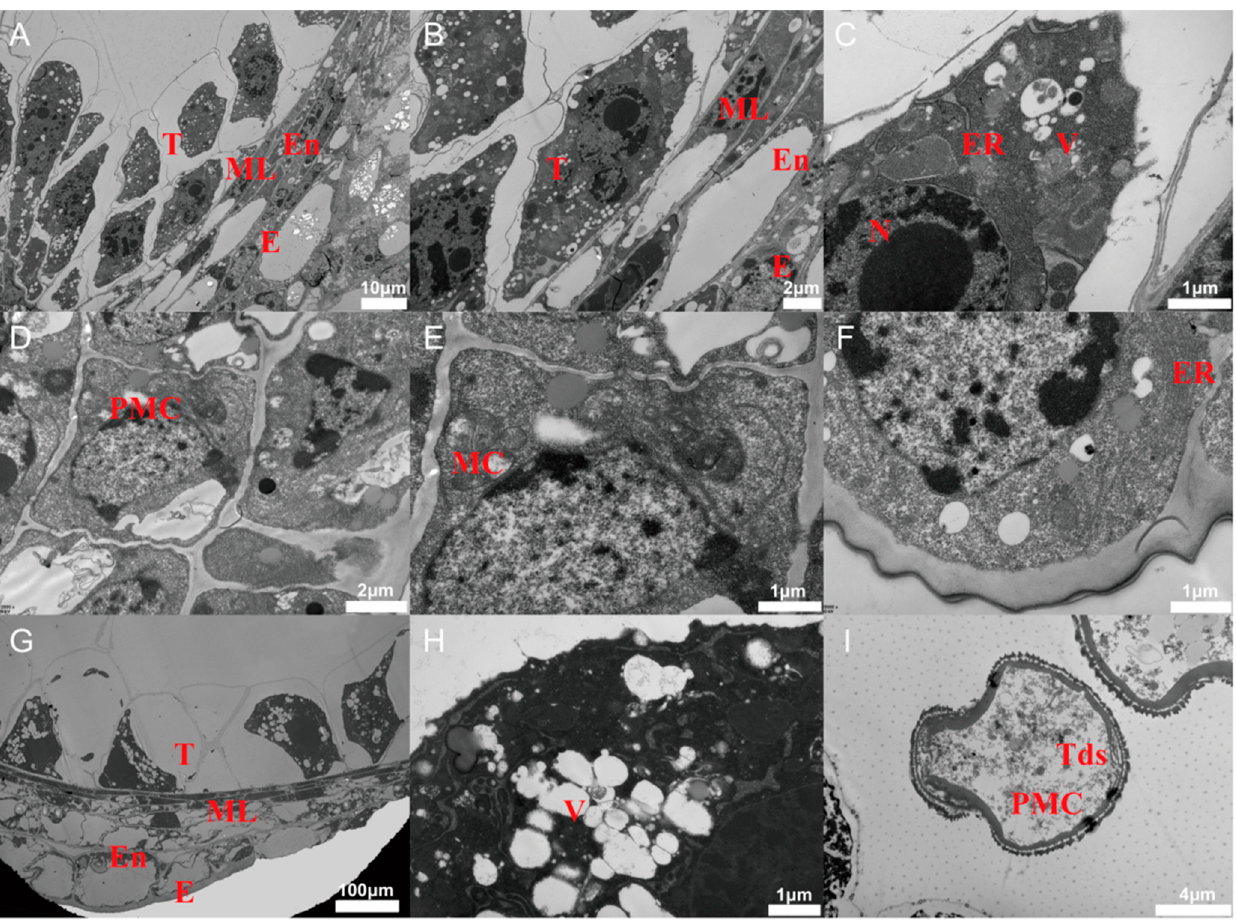
Figure 2. Anther ultrastructure of Ningqi No. 5 at Pm stage and Te stage. ( A ) Surface layer of pollen sac at Pm stage; ( B ) tapetal cell at Pm stage; ( C ) tapetal organelles at Pm stage; ( D ) pollen mother cell at Pm stage; ( E , F ) organelles in pollen mother cell at Pm stage; ( G ) anther surface layer at Te stage; ( H ) tapetal cells at Te stage; ( I ) pollen mother cell at Te stage. E, epidermis; EN, endothecium; ER, endoplasmic reticulum; MC, mitochondrion; ML, middle layer; N, nucleus; PMC, pollen mother cell; Po, pollen grain; SP, sporogenous cell; T, tapetum; Tds, tetrad; V, vacuole.